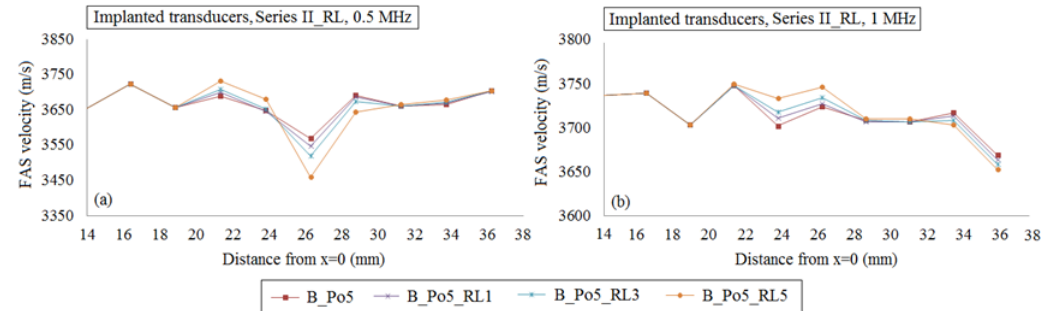
Figure 10. The potential of the local FAS velocity to detect the occurrence of a single or a cluster of RL considering cortical bone as a nonhomogeneous medium for the cases B_Po5, B_Po5_RL1, B_Po5_RL3 and B_Po5_RL5 (geometries illustrated in Figure 3f–h). The diagrams correspond to the second set of simulations under the assumption of implanted transducers and the excitation frequencies: ( a ) 0.5 MHz; and ( b ) 1 MHz.